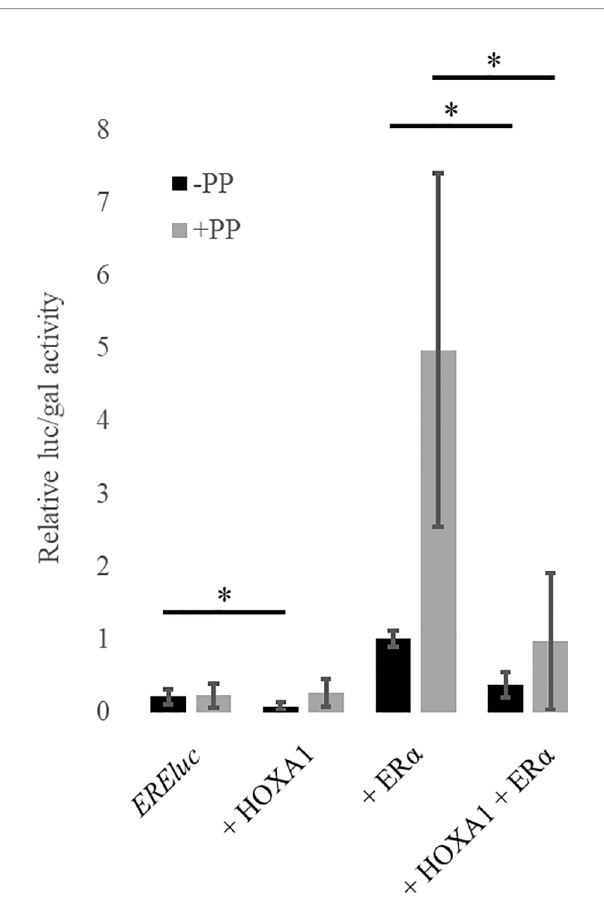
FIGURE 3 | HOXA1 inhibits ER a activity in presence and in absence of the cofactors, PREP1 and PBX1A. MCF10A cells were transfected with plasmids encoding ER a , Flag-HOXA1 along with CMV::lacZ and EREluc without (black boxes) or with (grey boxes) PREP1 and PBX1A (PP). ER-mediated luciferase activity (luc) was reported to the b -galactosidase activity (gal) (relative luc/gal activity). The activation of the ER reporter by ER a is reduced in presence of HOXA1 (black) and this effect is also observed in the presence of PREP1 and PBX1A (grey) (N ≥ 3). The relative EREluc activity in presence of ER a was set to 1. * means p < 0.05 (N ≥ 3, n=2). Error bars represent standard deviation; for N experiments and n replicates per